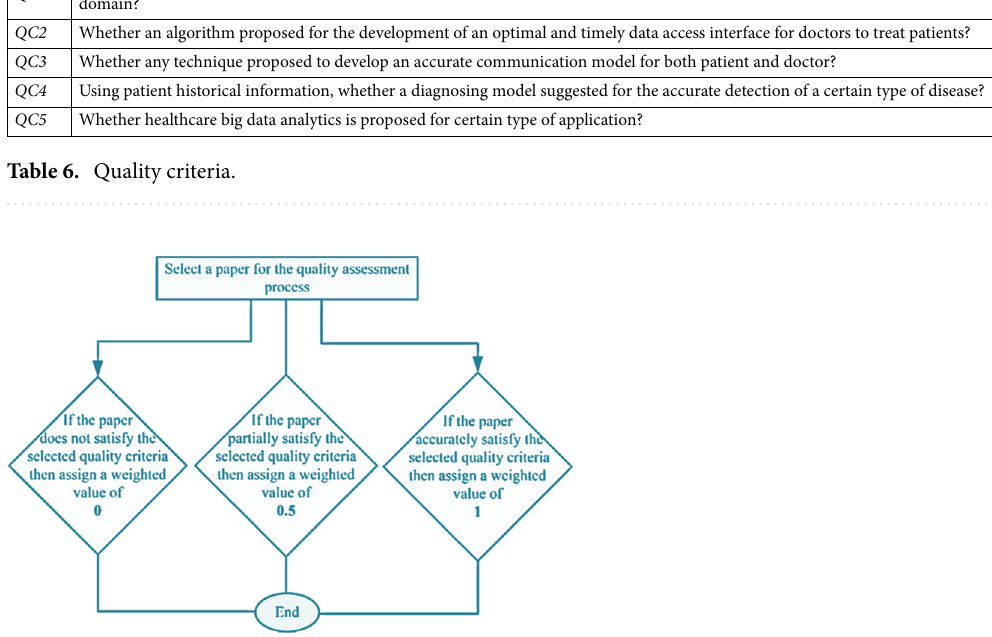
Figure 11. Quality criteria for the proposed SLR